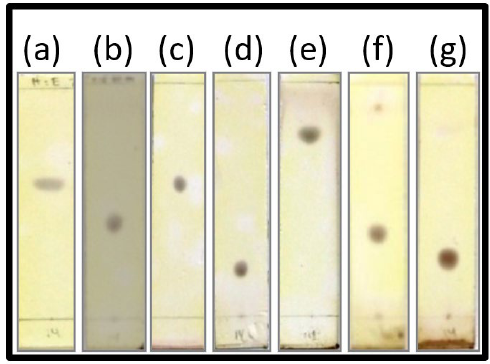
Fig. 4. Profiles of TLC chromatogram of fraction D8.3.5.7; (a) Eluent n-hexane : ethyl acetate 70% (Rf = 0.57), (b) Eluent n-hexane : ethyl acetate 80% (R = 0.42), (c) Eluent f CCl : ethyl acetate 70% (R = 0.57), (d) Eluent n-hexane : 4 f ethyl acetate 90% (R = 0.21), (e) Eluent n-hexane : ethyl f acetate 60% (R = 0.79), (f) Eluent Dichloromethane f (DCM) 100% (R = 0.36), (g) Eluent Chloroform (CHCl ) f 3 100% (Rf =